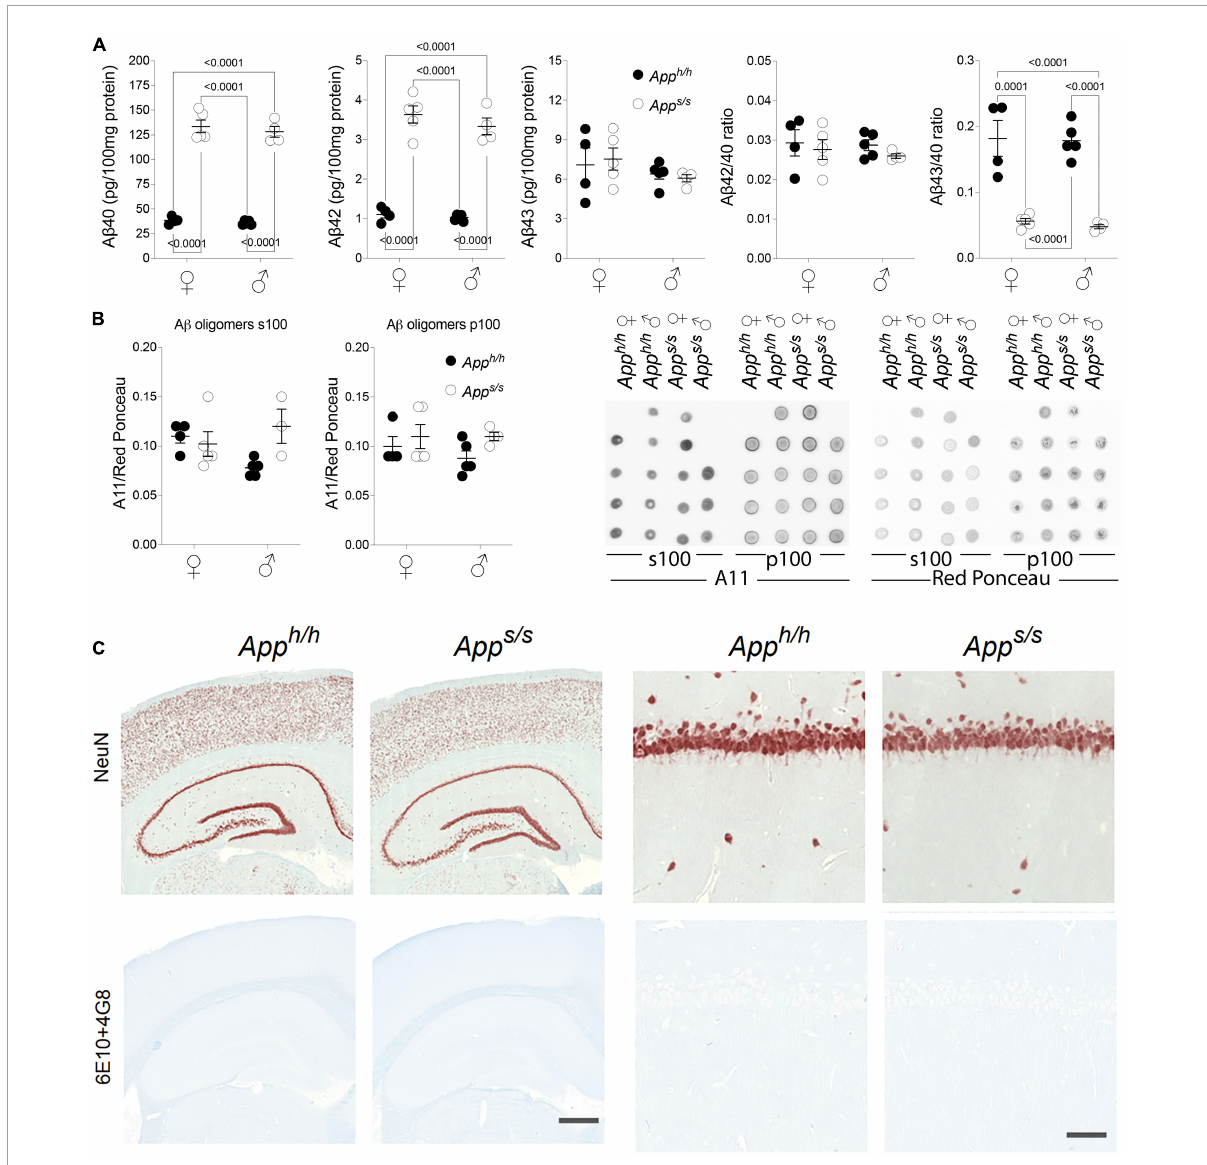
FIGURE5 Analysis of A β species and amyloid pathology in App h / h and App s / s rats brains. (A) ELISA levels of A β 40, A β 42 and A β 43 in App h / h females n = 4, App s / s females n = 5, App h / h males n = 5, App s / s males n = 4. Ratio of A β 42/A β 40 and A β 43/A β 40 are also presented. Data are represented as mean ± SEM and were analyzed by two–way ANOVA followed by post-hoc Sidak’s multiple comparisons test when ANOVA showed significant differences (A β 40: sex factor, F ( 1 , 14 ) = 0.7569, P = 0.3990; genotype factor, F ( 1 , 14 ) = 440.9, P < 0.0001; sex × genotype interaction, F ( 1 , 14 ) = 0.1036, P = 0.7523; post-hoc Sidak’s multiple comparisons test, female App h / h vs. female App s / s P < 0.0001; female App h / h vs. male App h / h P = 0.9993; female App h / h vs. male App s / s P < 0.0001; female App s / s . vs. male App h / h P < 0.0001; female App s / s . vs. male App s / s P = 0.9593; male App h / h vs. male App s / s P < 0.0001. A β 42: sex factor, F ( 1 , 14 ) = 1.379, P = 0.2598; genotype factor, F ( 1 , 14 ) = 224.3, P < 0.0001; sex × genotype interaction, F ( 1 , 14 ) = 0.4704, P = 0.5040; post-hoc Sidak’s multiple comparisons test, female App h / h vs. female App s / s P < 0.0001; female App h / h vs. male App h / h P = 0.9997; female App h / h vs. male App s / s P < 0.0001; female App s / s . vs. male App h / h P < 0.0001; female App s / s . vs. male App s / s P = 0.7560; male App h / h vs. male App s / s P < 0.0001. A β 43: sex factor, F ( 1 , 14 ) = 1.877, P = 0.1923; genotype factor, F ( 1 , 14 ) = 0.006110, P = 0.9388; sex × genotype interaction, F ( 1 , 14 ) = 0.2458, P = 0.6277. A β 42/A β 40: sex factor, F ( 1 , 14 ) = 0.2542, P = 0.6220; genotype factor, F ( 1 , 14 ) = 1.009, P = 0.3322; sex × genotype interaction, F ( 1 , 14 ) = 0.06414, P = 0.8037. A β 40/A β 43: sex factor, F ( 1 , 14 ) = 0.1730, P = 0.6838; genotype factor, F ( 1 , 14 ) = 83.80, P < 0.0001; sex × genotype interaction, F ( 1 , 14 ) = 0.03059, P = 0.8637; post-hoc Sidak’s multiple comparisons test, female App h / h vs. female App s / s P = 0.0001; female App h / h vs. male App h / h P > 0.9999; female App h / h vs. male App s / s P < 0.0001; female App s / s . vs. male App h / h P < 0.0001; female App s / s . vs. male App s / s P = 0.9990; male App h / h vs. male App s / s P < 0.0001). (B) Quantitation of oligomeric A β detected by dot-blots using the oligomer-specific antibody A11. Both the s100 and p100 brain fractions were tested. Before immunoblot analysis, membranes were stained with Ponceau red. Quantitative analysis of A11 blot was normalized to the Ponceau red quantitative analysis. We analyzed: App h / h females n = 4, App s / s females n = 5, App h / h males n = 5, App s / s males n = 4. However,